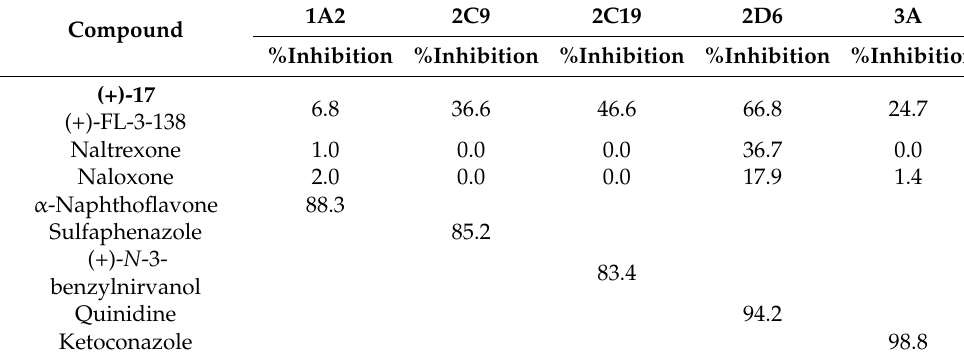
Table 3. Effect of test compounds at 10 µ M on P450